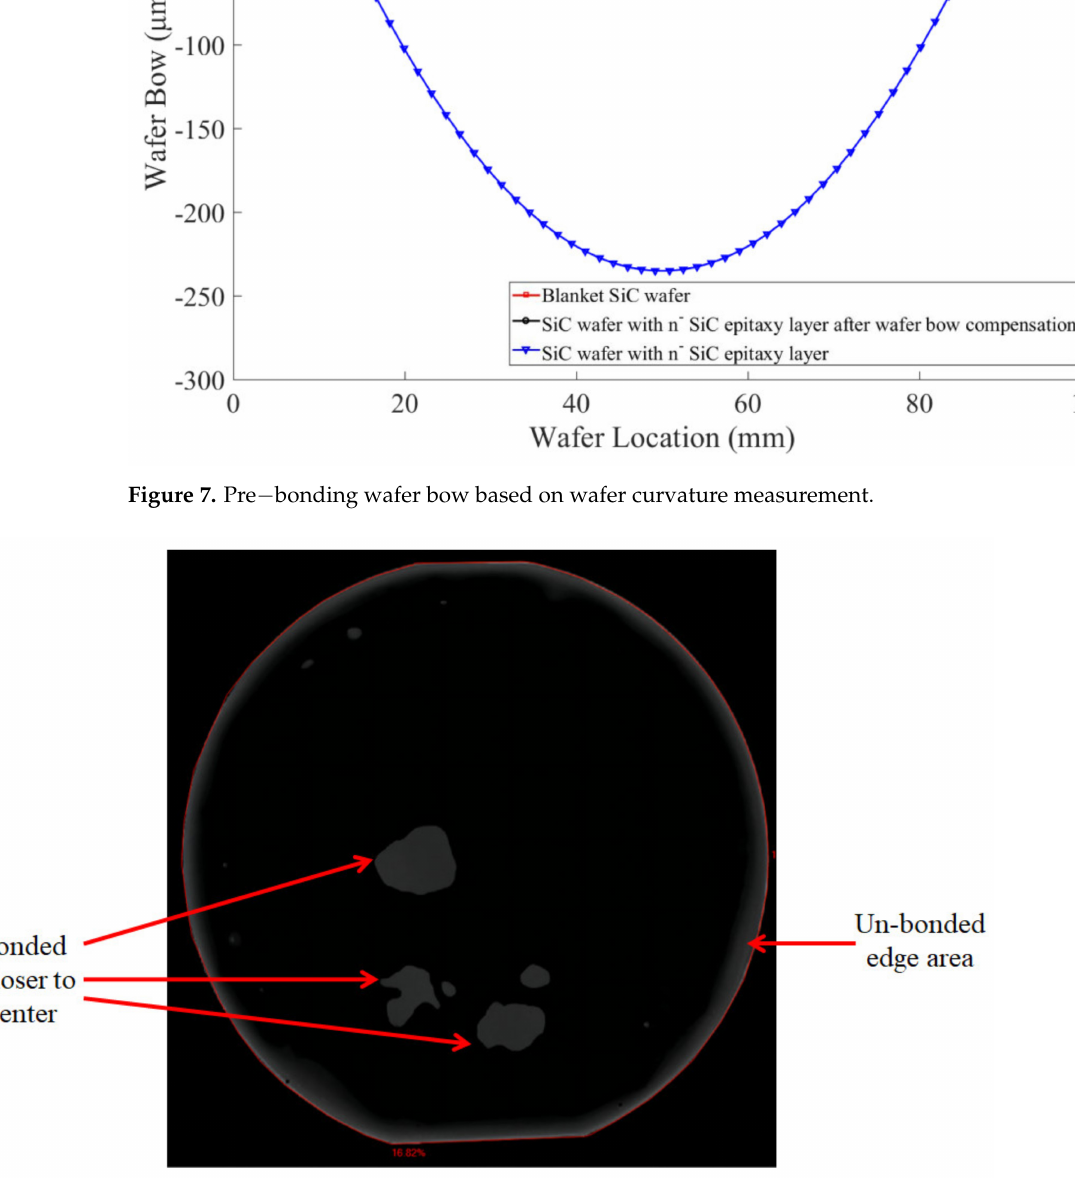
Figure 8. C-SAM scan image for bonded wafer